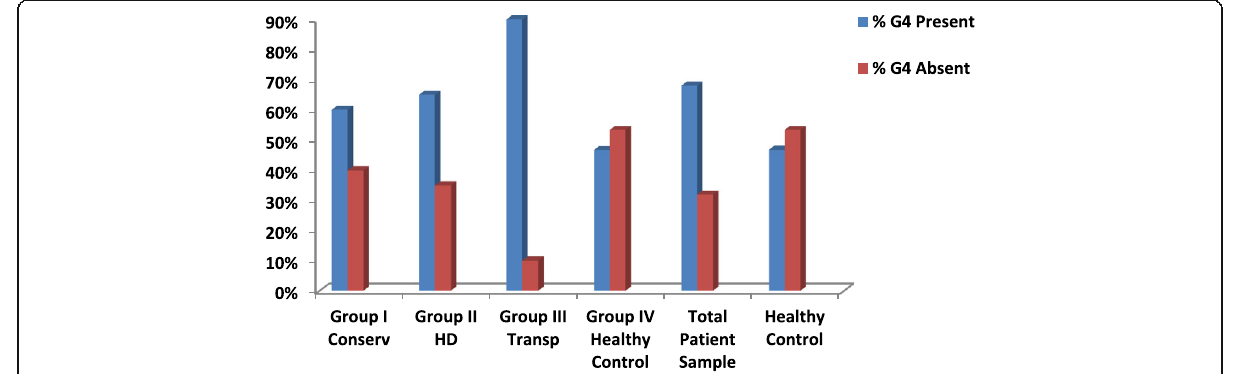
Fig. 4 Frequency distribution of groups according to the presence of G4 polymorphism